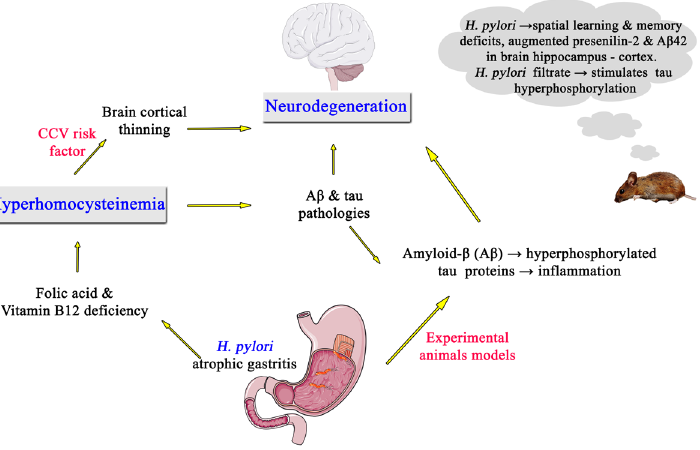
Figure 2. Schematic illustration of proposed pathophysiological mechanism (s) connecting Helicobacter pylori infection and neurodegeneration through the hyperhomocysteinemia pathway. CCV, cardio-cerebrovascular disorders; H. pylori, Helicobacter pylori.